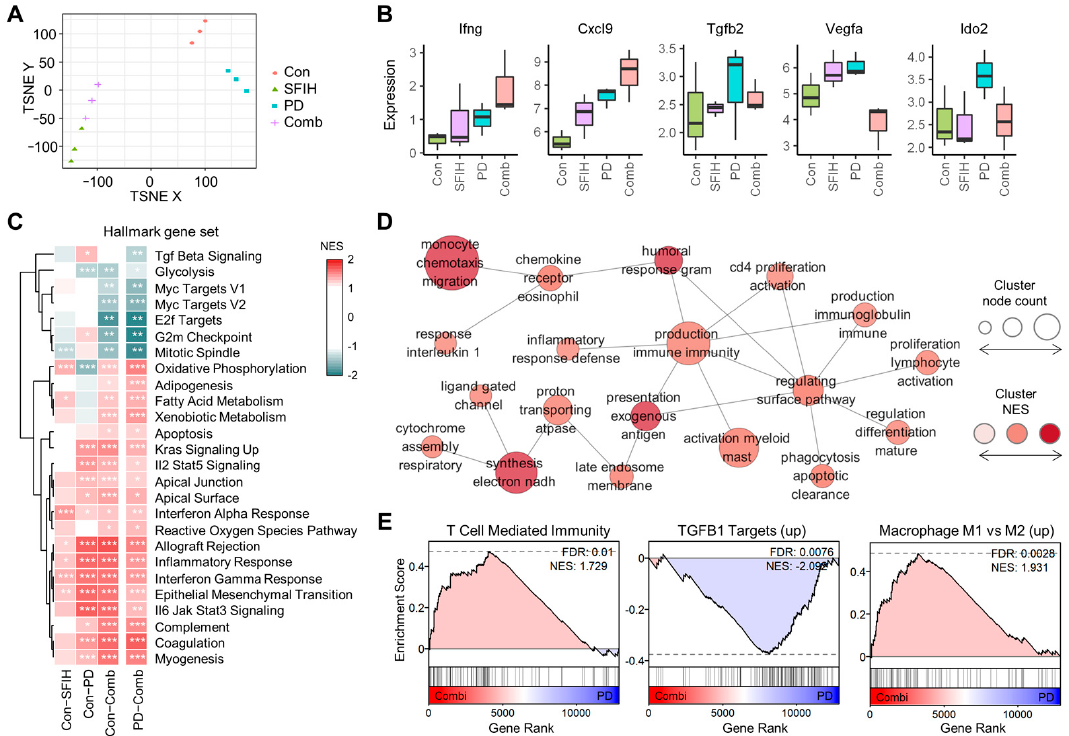
Figure 6. Transcriptomic analysis of combined treatment with SFIH and anti-PD-1. ( A ) Cluster analysis with the gene expression data from the four mouse groups. ( B ) Expression levels of five selected genes in the four mouse groups. The levels were calculated as log 2 (TPM + 1). ( C ) GSEA results using the hallmark gene set. Normalized enrichment score (NES) values are indicated by colors and adjusted p -values are denoted by asterisks as follows: * padj < 0.05, ** padj < 0.01, and *** padj < 0.005. Only results with significant changes in the combined treatment compared with the anti-PD-1 treatment (“PD-Comb”) are shown. ( D ) The largest increased component in the simplified network from the GSEA results of PD-Comb using the GO terms. Each node represents a cluster of integrated similarly enriched terms, named with common keywords for the terms included. ( E ) The GSEA results of PD-Comb for “GOBP_T_CELL_MEDIATED_IMMUNITY” (left), “KARLSSON_TGFB1_TARGETS_UP” (middle), and “COATES_MACROPHAGE_M1_VS_M2_UP” (right). Con, control group; SFIH, SFIH treatment group; PD, anti-PD-1 treatment group; Comb, SFIH + anti-PD-1 antibody treatment